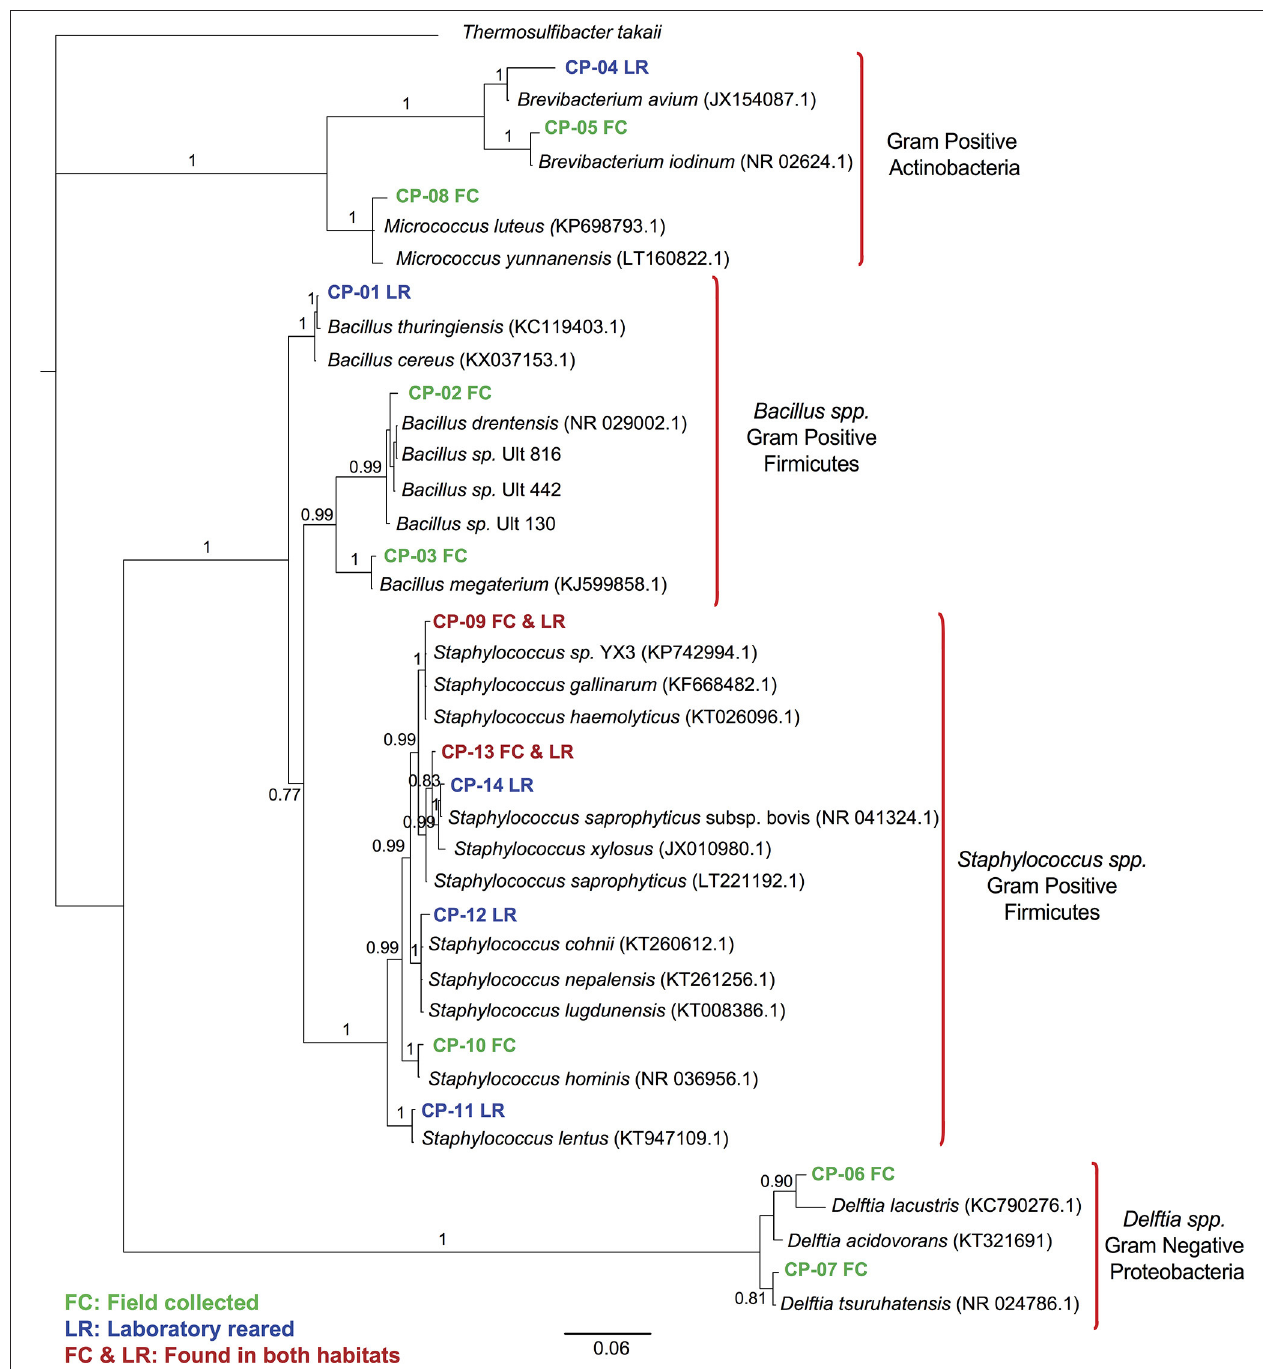
FIGURE 1 | 16S rRNA gene sequence phylogenetic tree of Triatoma dimidiata bacterial symbionts. Bayesian bacterial symbionts phylogeny from all 16S rRNA gene amplicons sequenced from field-collected and laboratory-reared Triatoma dimidiata specimens. Amplicons from our study are labeled CP, whereas species included in the tree are the most closely related bacterial species found on GeneBank. Numbers on branches represent posterior probabilities from the Bayesian analysis.